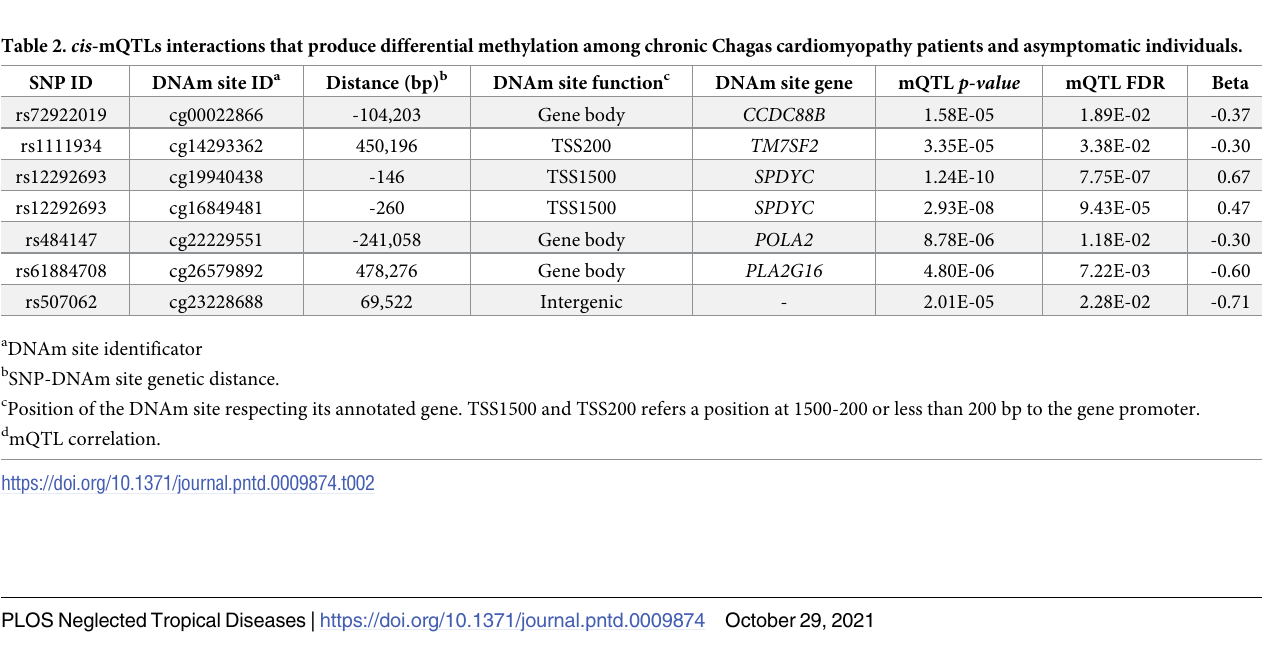
Table 2. cis -mQTLs interactions that produce differential methylation among chronic Chagas cardiomyopathy patients and asymptomatic individuals. SNP ID DNAm site ID a Distance (bp) b